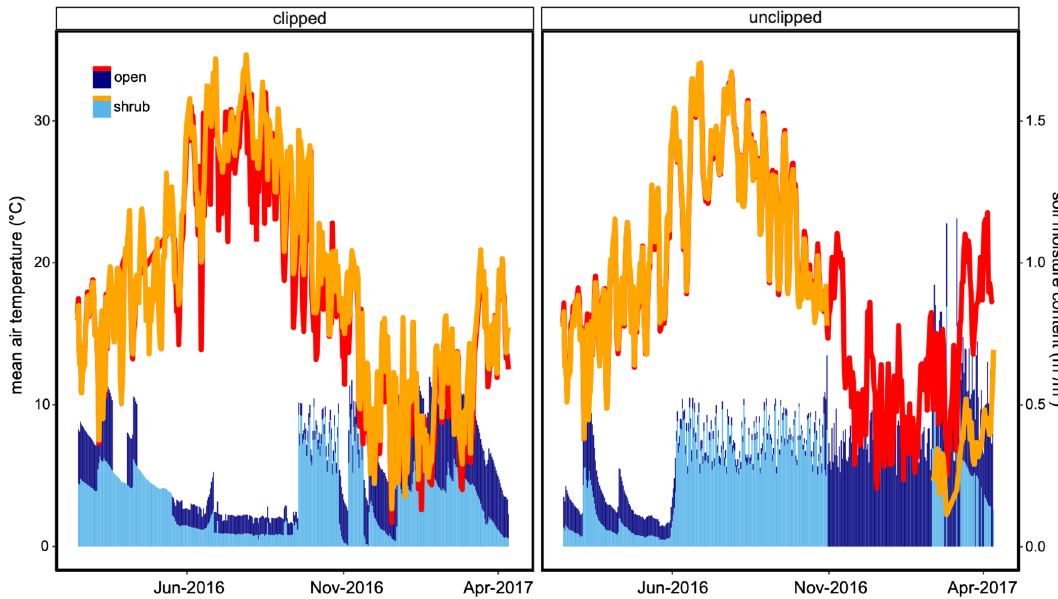
Figure 3. A climatograph of ecologically structured fine-scale climate observations instrumented in Cuyama Valley, California in 2016 and the winter of 2017. Near-surface mean air temperature and soil moisture were sampled under shrub canopy microsite and in the open without a canopy but with ground cover vegetation present. The clipped versus unclipped panels describe a treatment removing all non-woody vegetation from near instrumentation in each microclimatic content examined. These data were collected during the extended SWNA megadrought. The top lines show mean daily temperature in red and orange, and the lower bars show mean daily soil moisture content in light and dark blue for each microsite classification. Data models, statistical analyses, and visualization for this figure were done in R version 4.2.1 (see Supplement for full script and